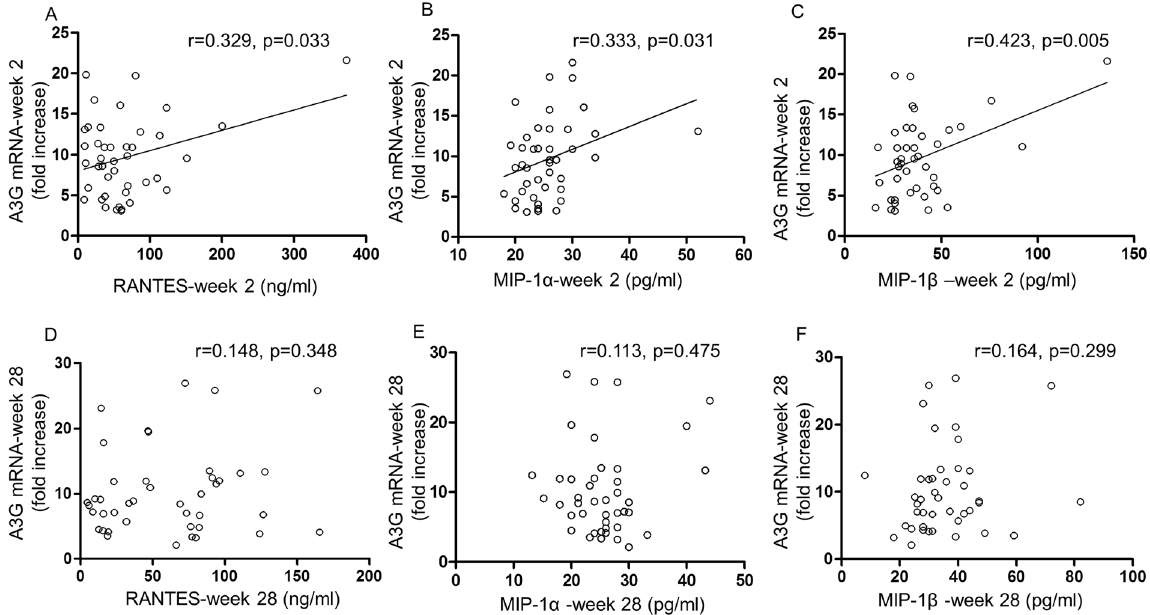
Figure 7. Correlation studies between RANTES, MIP-1 α and MIP-1 β CC chemokines and A3G mRNA showed significant direct correlation between them 2 weeks post-immunization ( A , B , C ), but was not maintained by 28 weeks ( D – F ); analysed by Spearman rank correlation coefficient; (n = 42 all from different